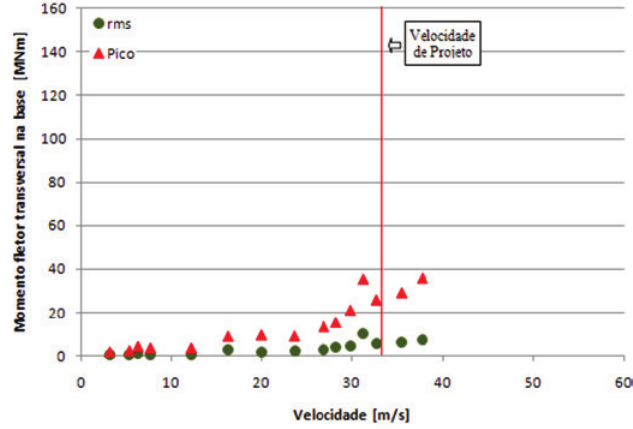
Figure 12 Longitudinal bending moment at the base of the chimney as a function of the wind speed at the top of the structure. Isolated configuration